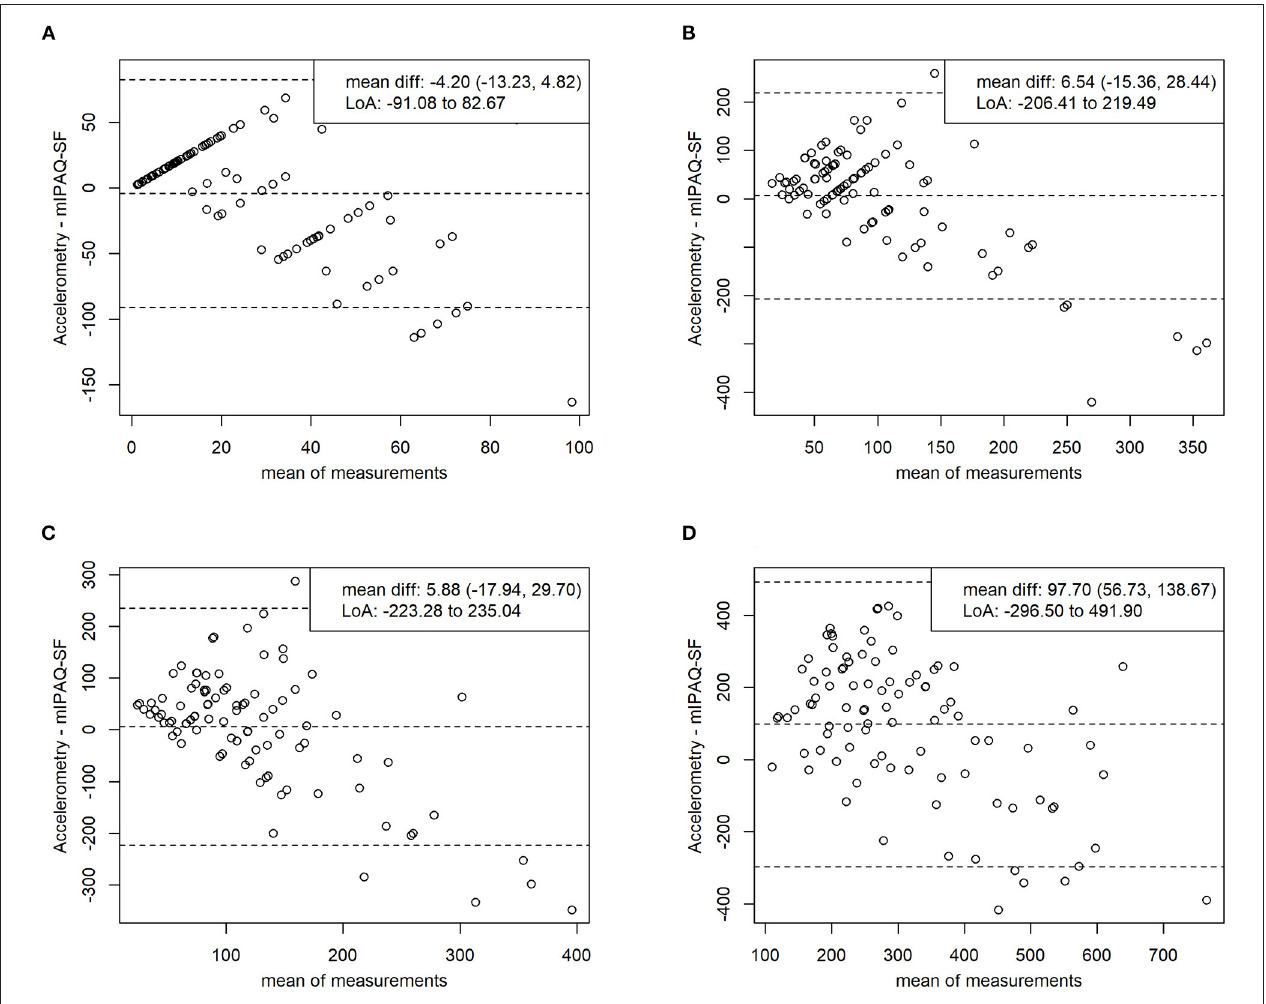
FIGURE 1 | Bland-altman plots validity. Comparing average minutes intensive per day (A) , average minutes moderate per day (B) , average minutes moderate to vigorous per day (C) , average minutes total physical activity (D) between mIPAQ-SF and accelerometry. Accelerometry – mIPAQ-SF: difference between